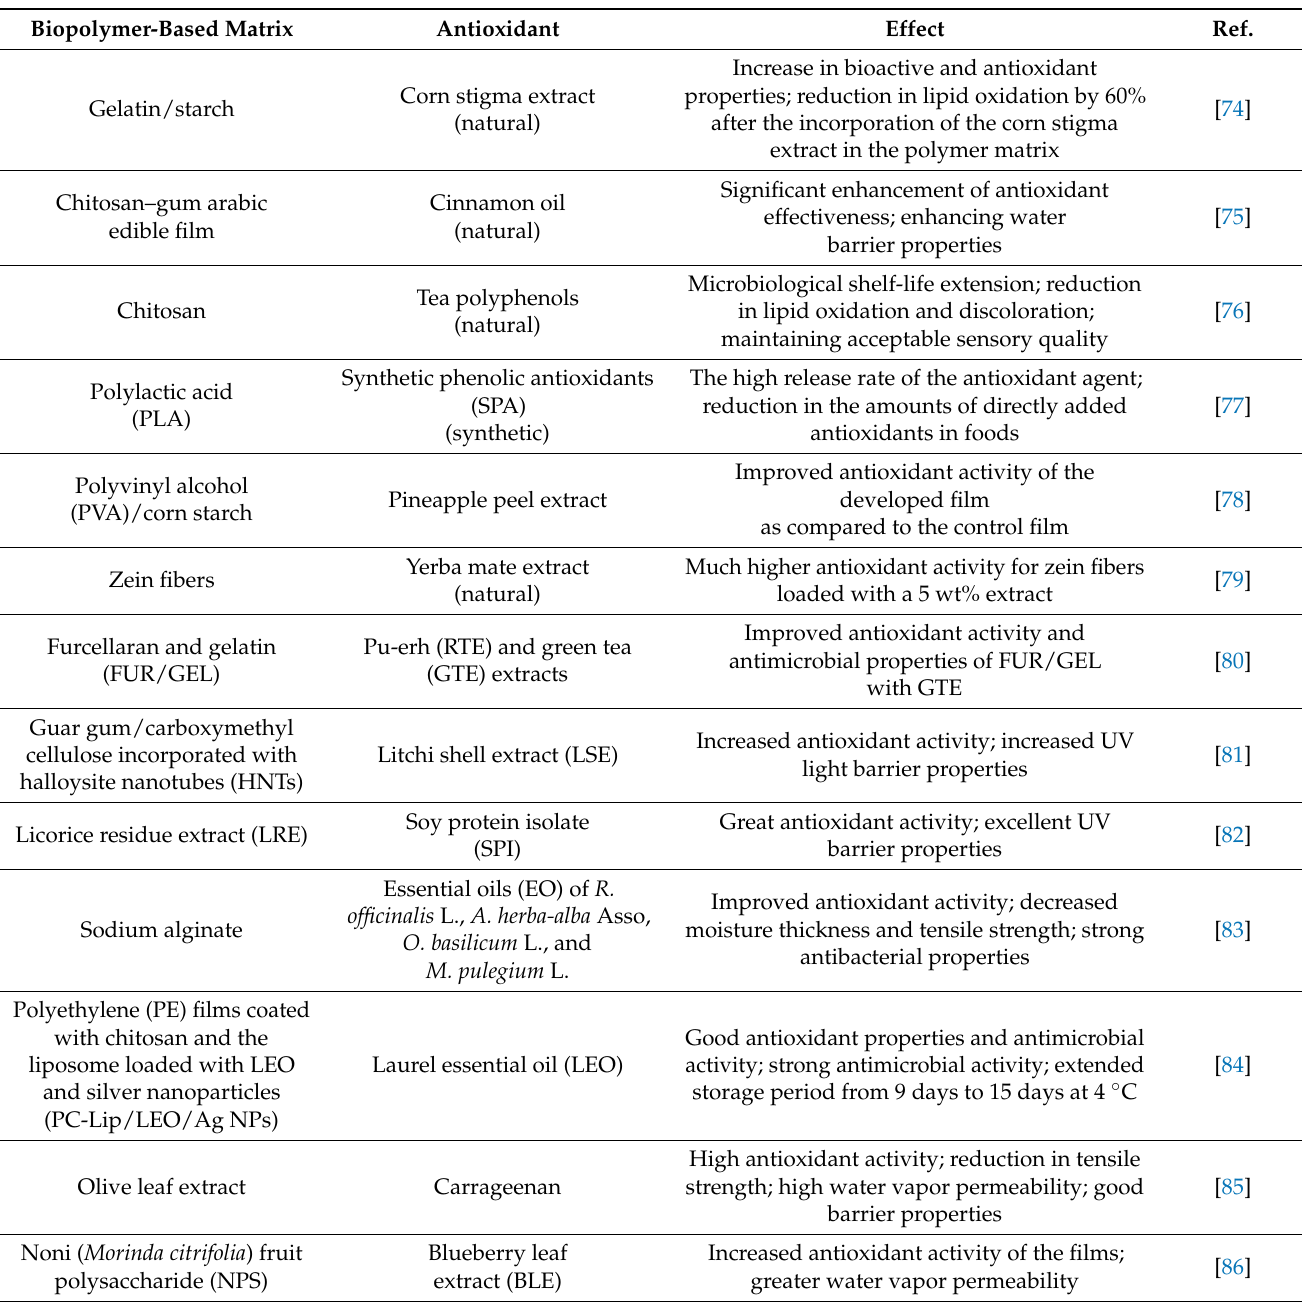
Table 1. Biopolymer-based matrices containing antioxidant agents for active food